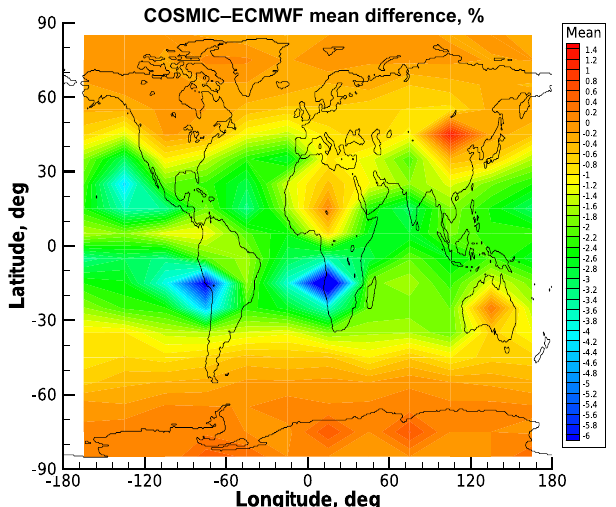
Figure 3. Deviation statistics obtained for real RO data: latitude– longitude map (10 ◦ lat × 30 ◦ long grid resolution) of difference statistics of COSMIC observations relative to ECMWF profiles without fluctuations for refractivity at an altitude of 0.6km. Results are shown for COSMIC events and concurrent ECMWF analysis fields from the 1st, 11th, and 21st day of every month of year